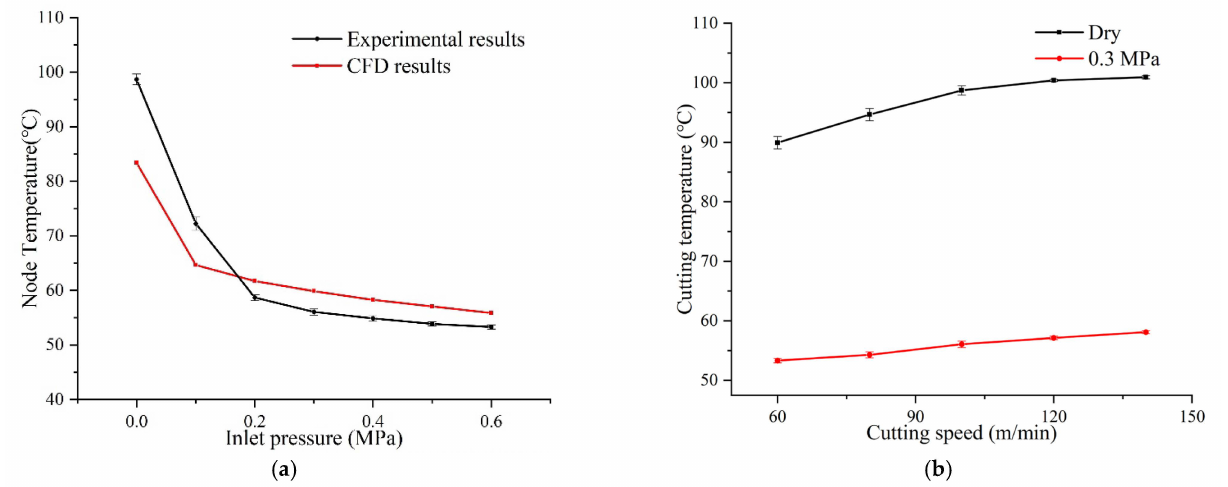
Figure 12. Effect of cooling conditions on cutting temperature. ( a ) cutting temperature under different spray pressure, ( b ) the influence of cutting speed on cutting temperature under dry cutting and internal spray